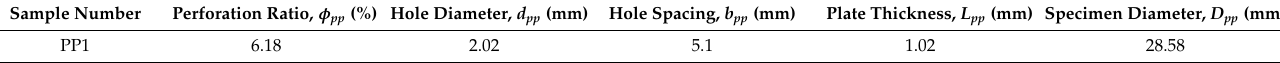
Table 3. The measured parameters for PP1 test